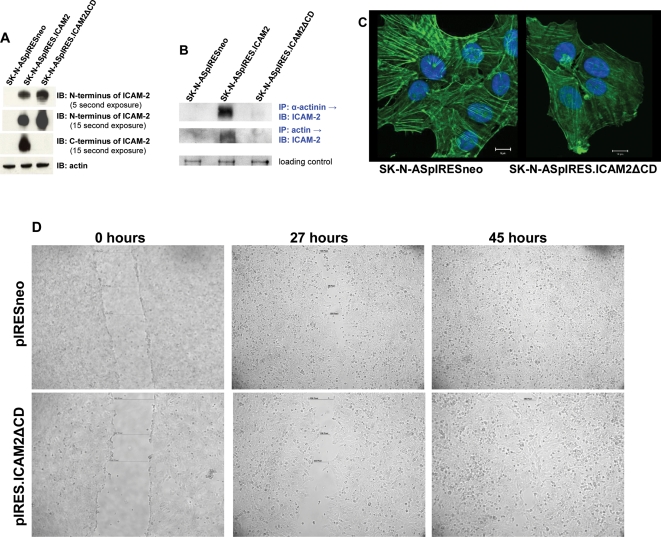
The effect of ICAM-2 on actin distribution and cell motility depends on an intact intracellular domain.A) SK-N-AS cells were transfected to express a truncated form of ICAM-2 with a deleted cytoplasmic domain (ICAM2ΔCD). Expression of full length ICAM-2 and ICAM2ΔCD was similar in respective transfected cell lines. B) ICAM-2, α-actinin, and actin co-precipitated only in transfectants expressing full length ICAM-2. C) ICAM2ΔCD had no effect on actin fiber distribution. (Compare with Fig. 2A). D) ICAM2ΔCD did not affect migration of SK-N-AS cells in scratch assays. Pixel width of scratches for pIRESneo and pIRES.ICAM2ΔCD transfectants at 0 hours and 27 hours were similar. No gap remained for either cell line 45 hours after scratch.